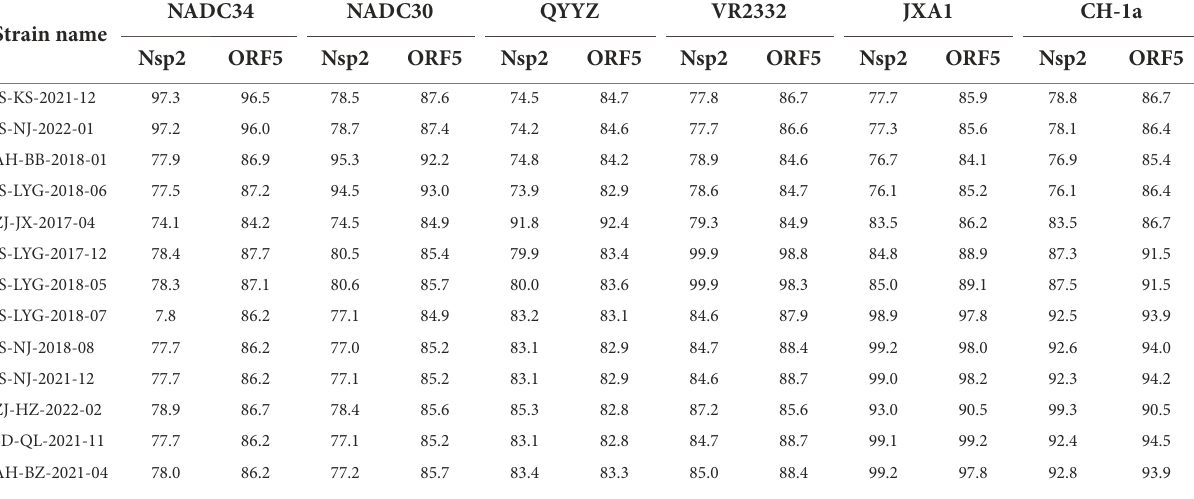
TABLE 4 Nsp2 and ORF5 genomic nucleotide identity between the 13 isolates and PRRSV reference